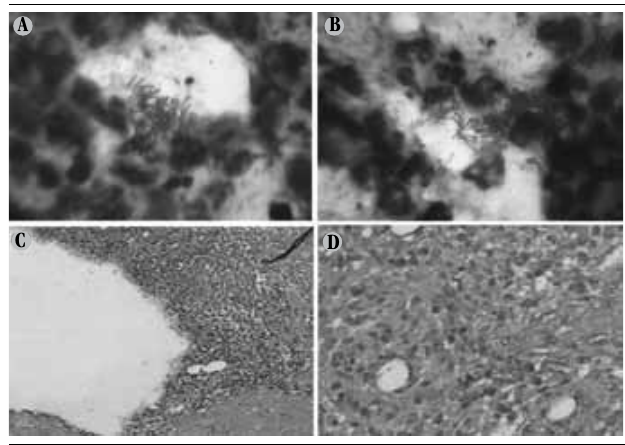
figurE 2 – RAFB screening and anatomopathologic exam (a) and (b) resistant acid-fast bacilli visualized under optical microscopy at 1,000×. Samples were obtained from the lesion site and underwent Ziehl-Neelsen staining; (c) and (d) suppurative granuloma at 40× and 400×, respectively. RAFB: resistant acid-fast